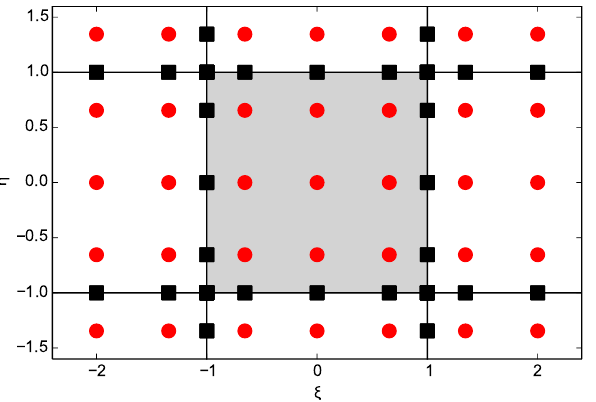
Figure 4. Lagrange interpolation points inside an element (gray) and its neighbors. Coordinates ξ and η are the reference coordinates of the gray element. Points on the edges (black squares) are shared between neighbors and function values at these points need to be stored only once if the function is continuous (e.g. displacement). The number of global degrees of freedom per element of such func- tions is thus approximately 16 compared to 25 for discontinuous functions (e.g. strain).